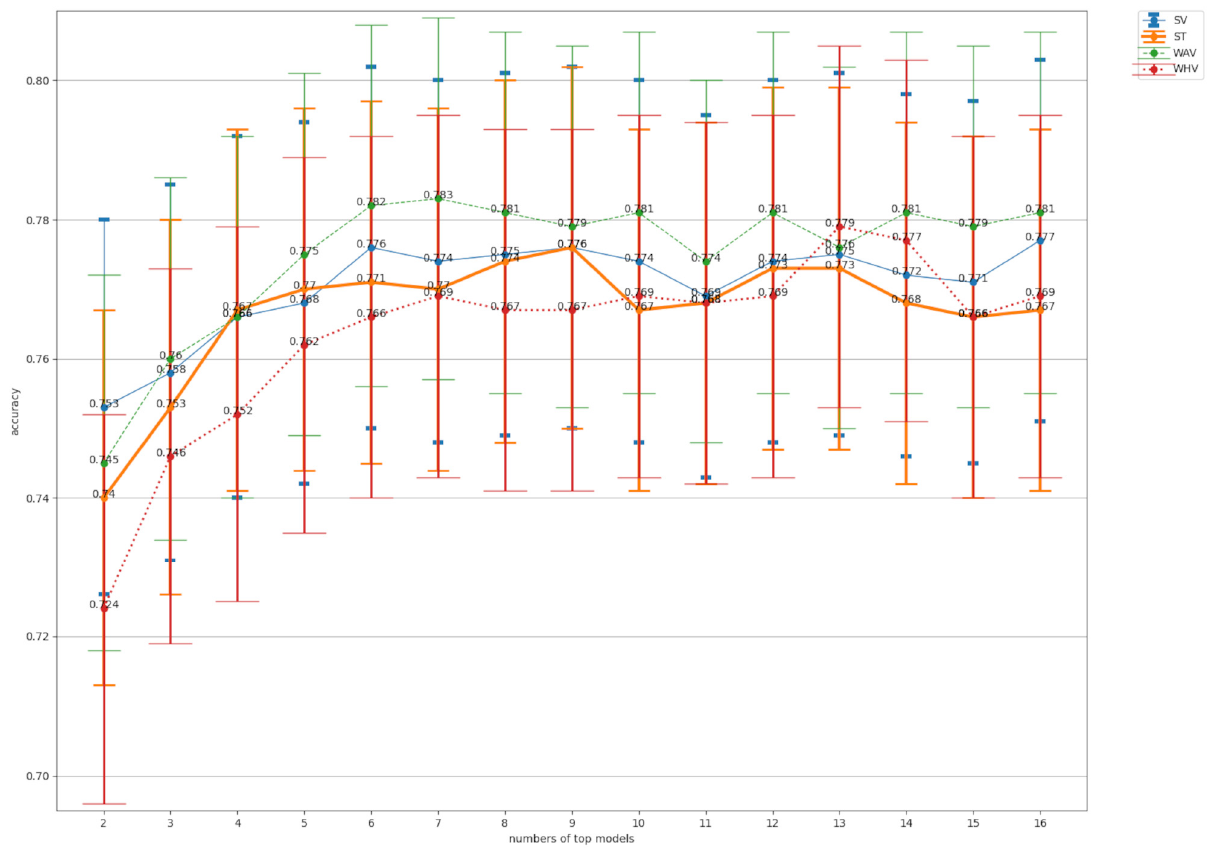
Figure 6. A comparison of the accuracy values for ensemble pruning. SV: soft voting, ST: stacking. WAV: weighted average voting, WHV: weighted hard voting. Numbers of top models represents the number of classifiers used for ensemble training from top 2 to top 16 in accuracy. The bars in the graph are 95% confidence intervals.